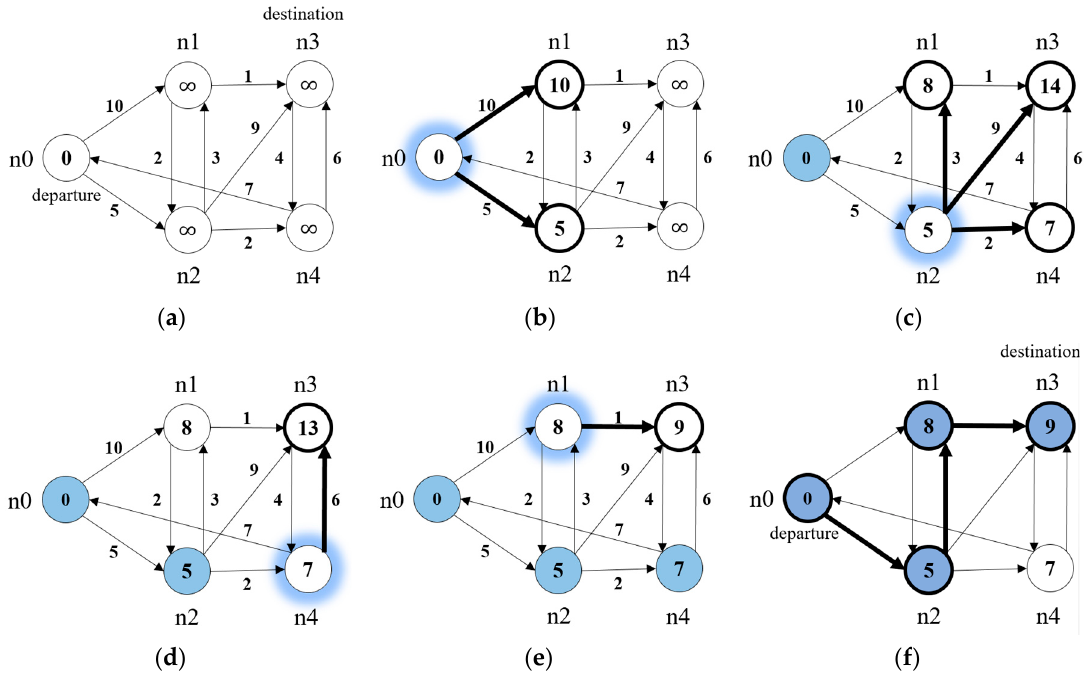
Figure 2. Example of analyzing the optimal path through a vector network using Dijkstra’s algorithm.